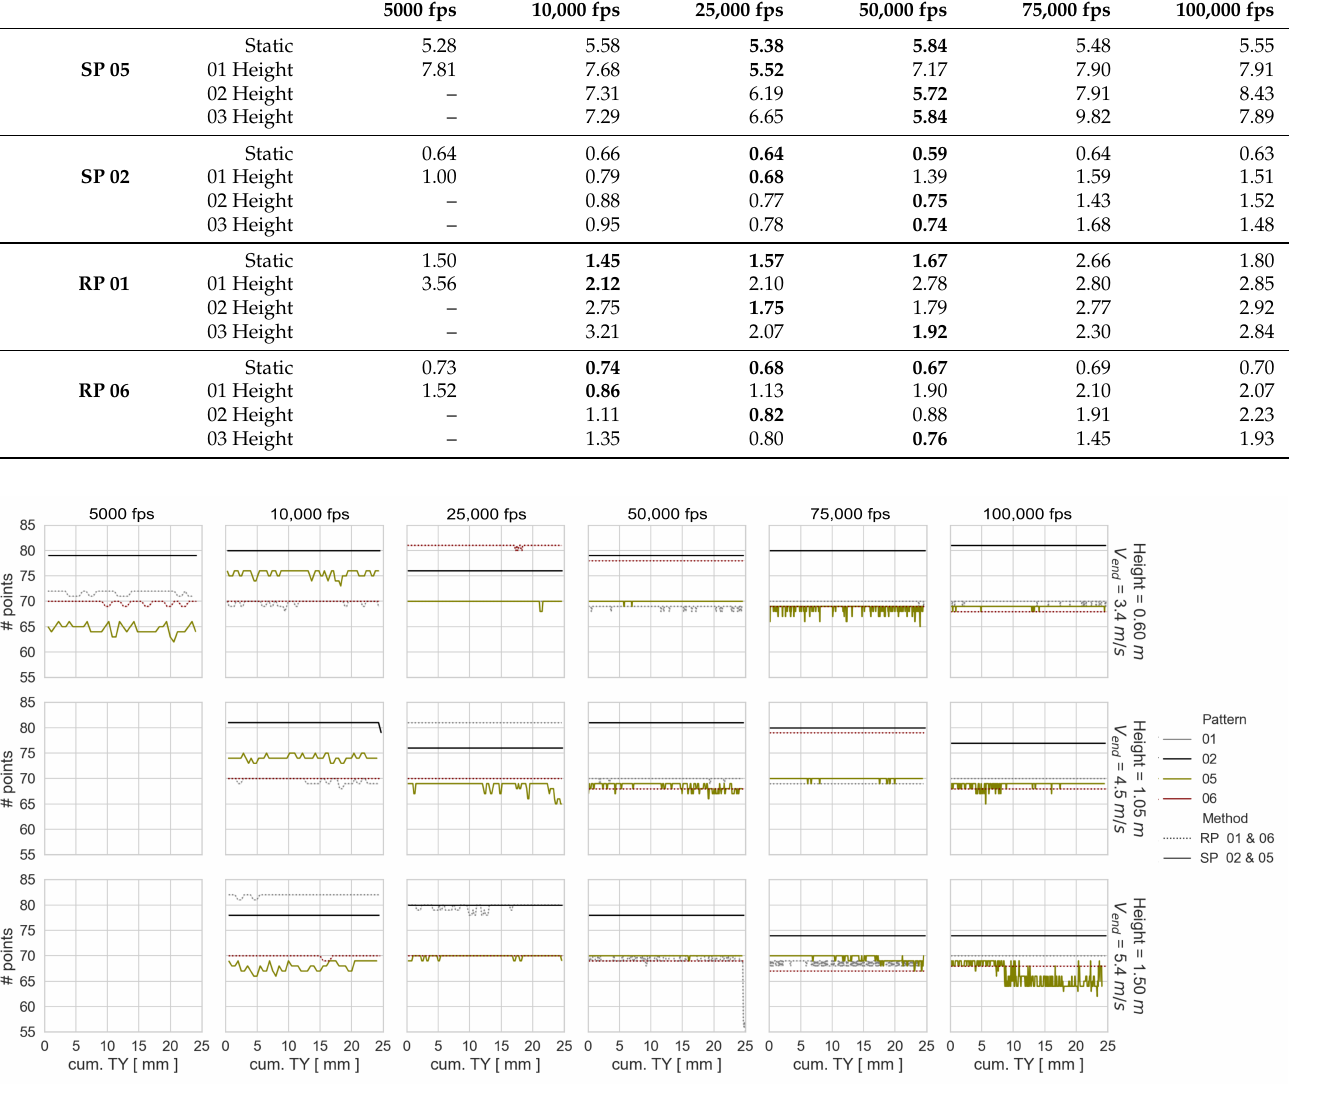
Figure 11. Number of tracked points per time step and vertical cumulative object translation ( TY ). The performance of the worst patterns is the result of a fluctuating number of tracked points over time and a larger distance between them. The higher performance of SP 02 compared to RP 06 is due to the higher number of tracked points and the associated smaller distance between them. When analyzing the behavior of the number of tracked points and the average distance between them by experimental configuration, it can be noted that in general the results are noisier with higher drop-weight velocity and image frequency. Furthermore, the number of points fluctuates more than the distance between them. This means that the surface geometry obtained from an experiment is not affected by the frame rate